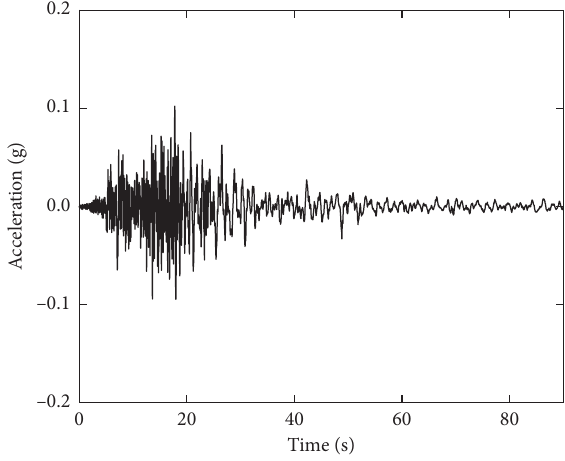
Figure 3: The dynamic input (at the depth of − 7m).